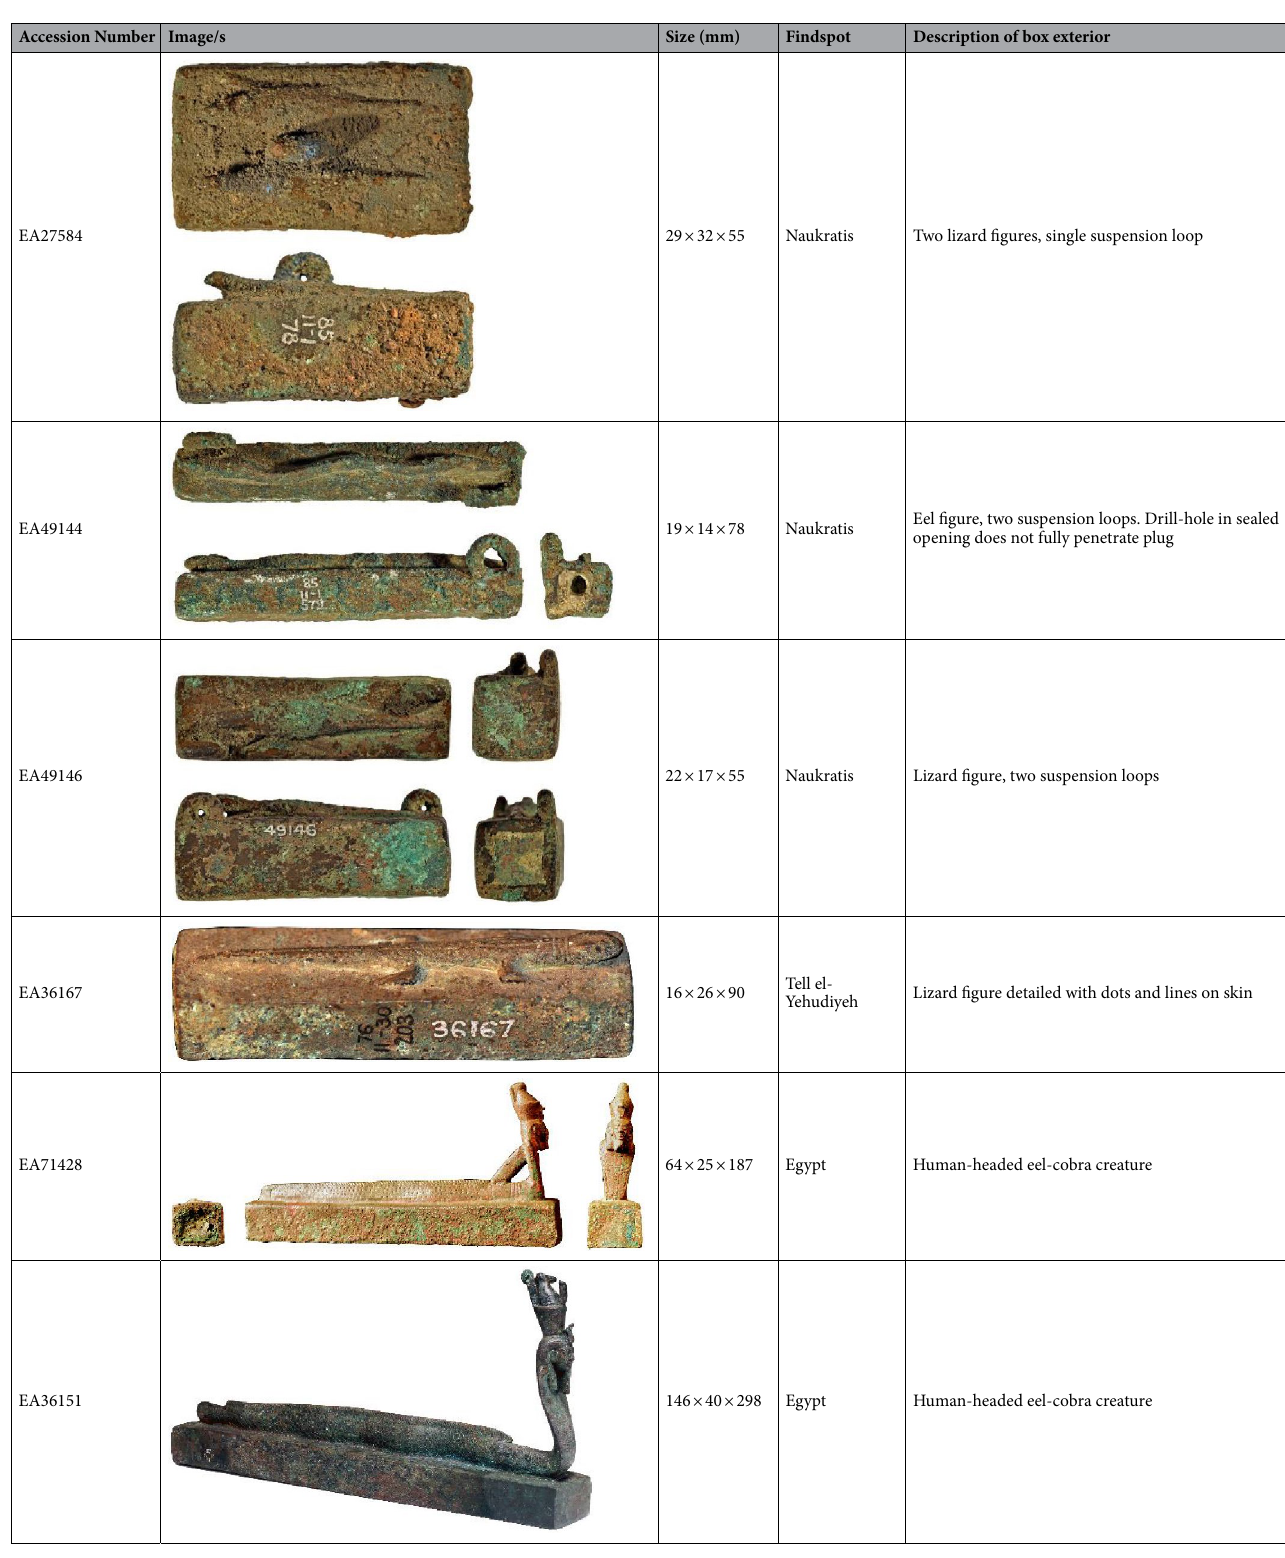
Table 1. Descriptions of the boxes investigated in this study (images not to scale). Photographs © The Trustees of the British Museum, and shared under a CC-BY-NC-SA 4.0 license.